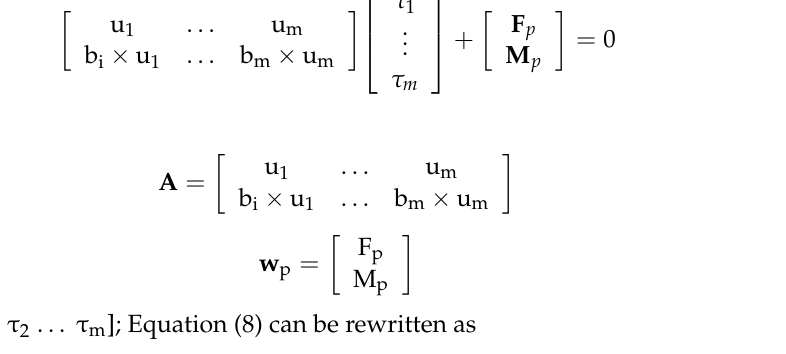
ics of the CDPRs; from (5) and (6) we can have